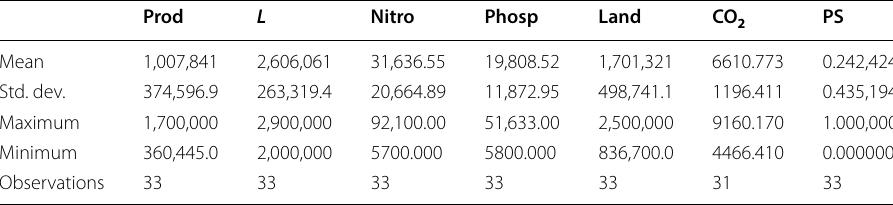
Table 2 General descriptive